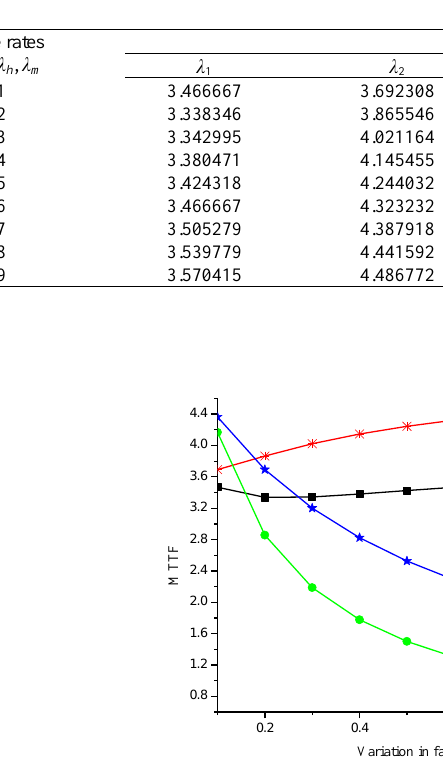
Table 10. MTTF of the system without copula-coverage.